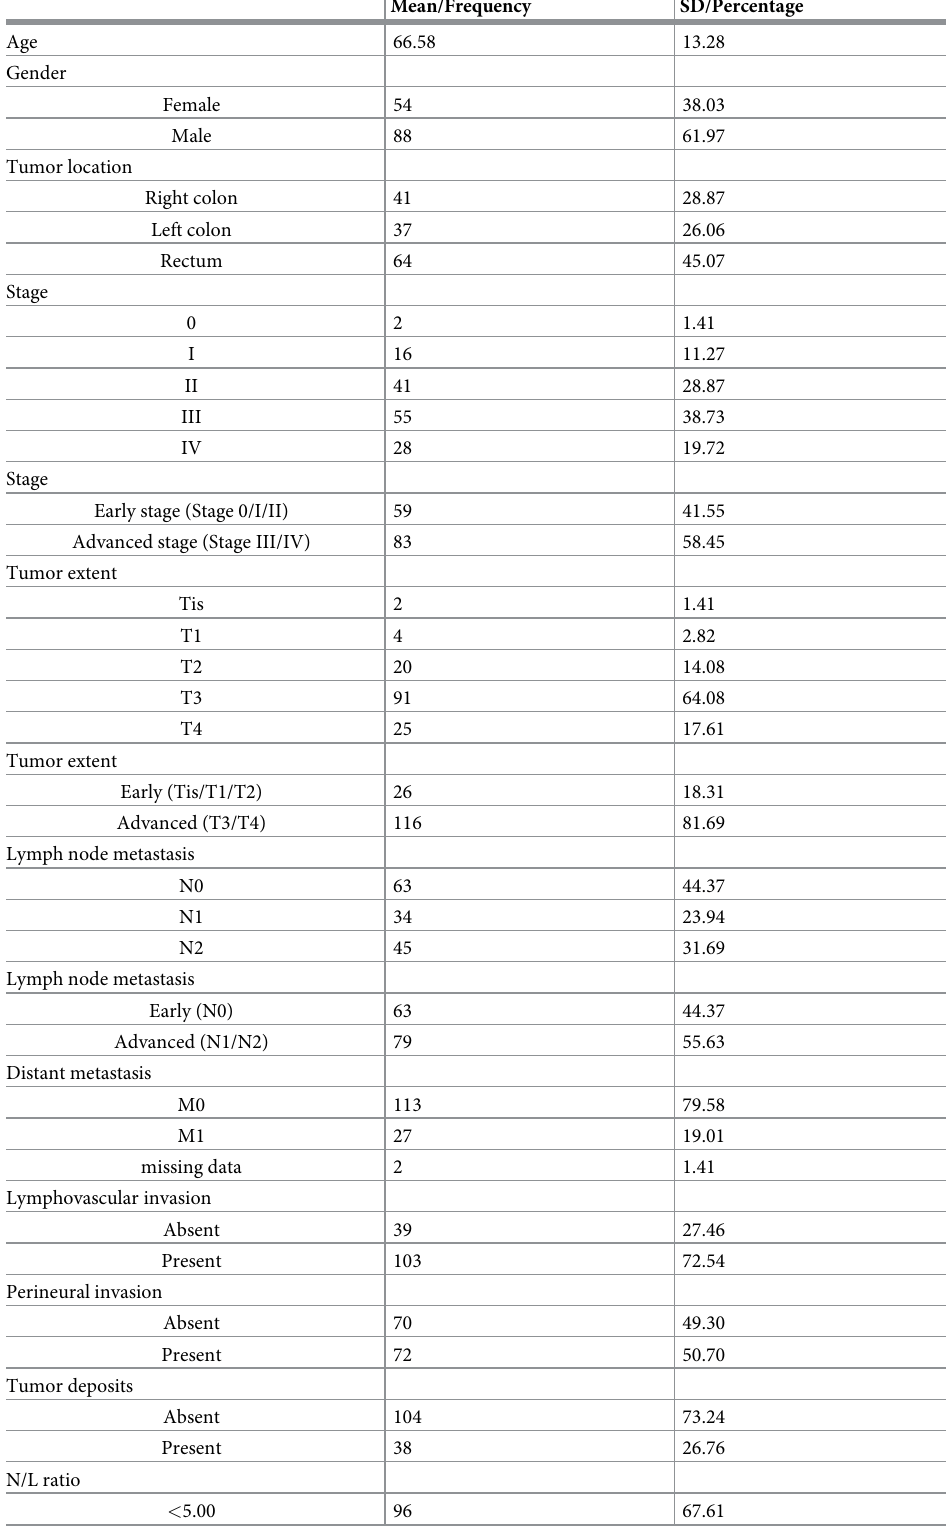
Table 1. Clinicopathologic data of the colorectal cancer cohort.